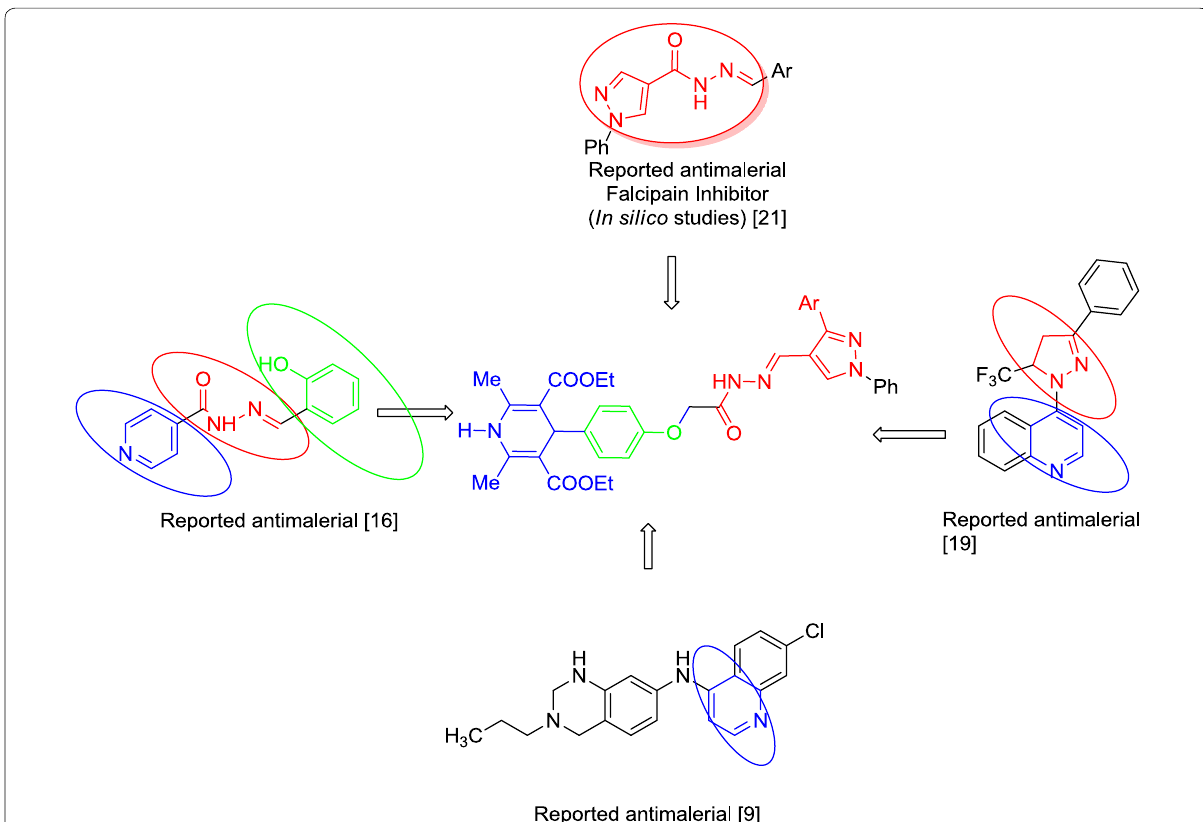
Fig. 1 Drug designing by molecular hybridisation approach for the synthesis of new molecular